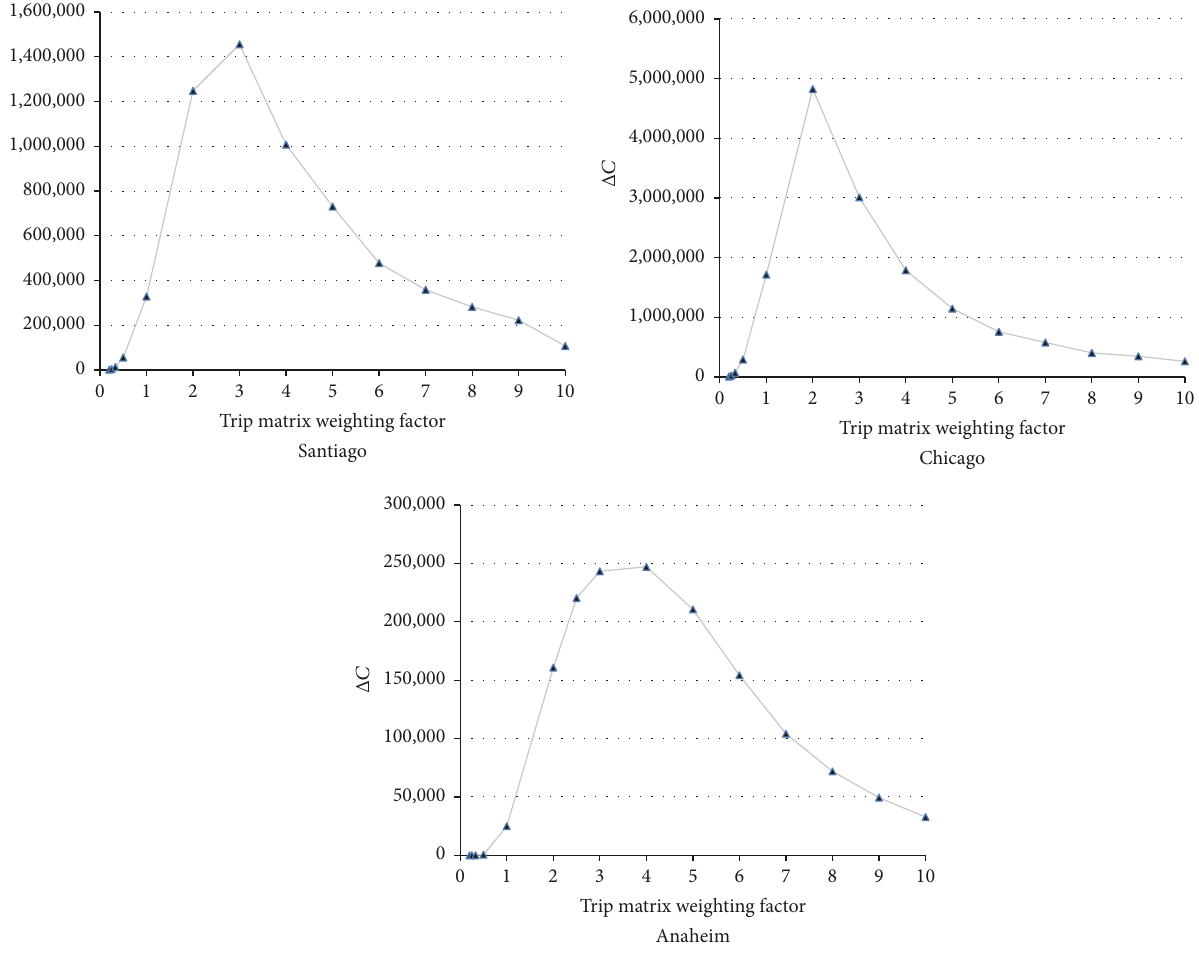
Figure 4: Relationship between Δ𝐶 and the demand level in each network.